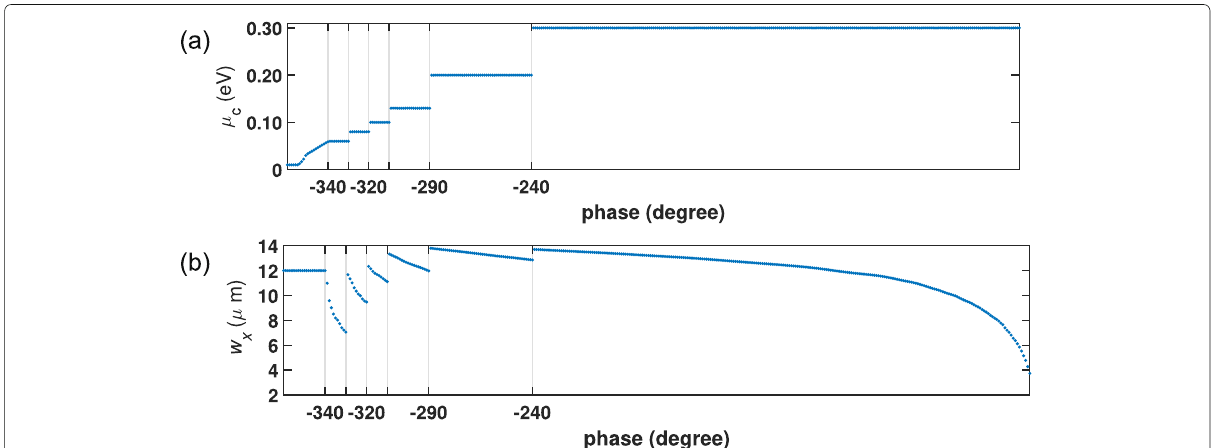
Fig. 3 Design diagram of graphene cell. A full 360 ◦ phase coverage achieved by seven groups of combinations of a chemical potential and b patch size